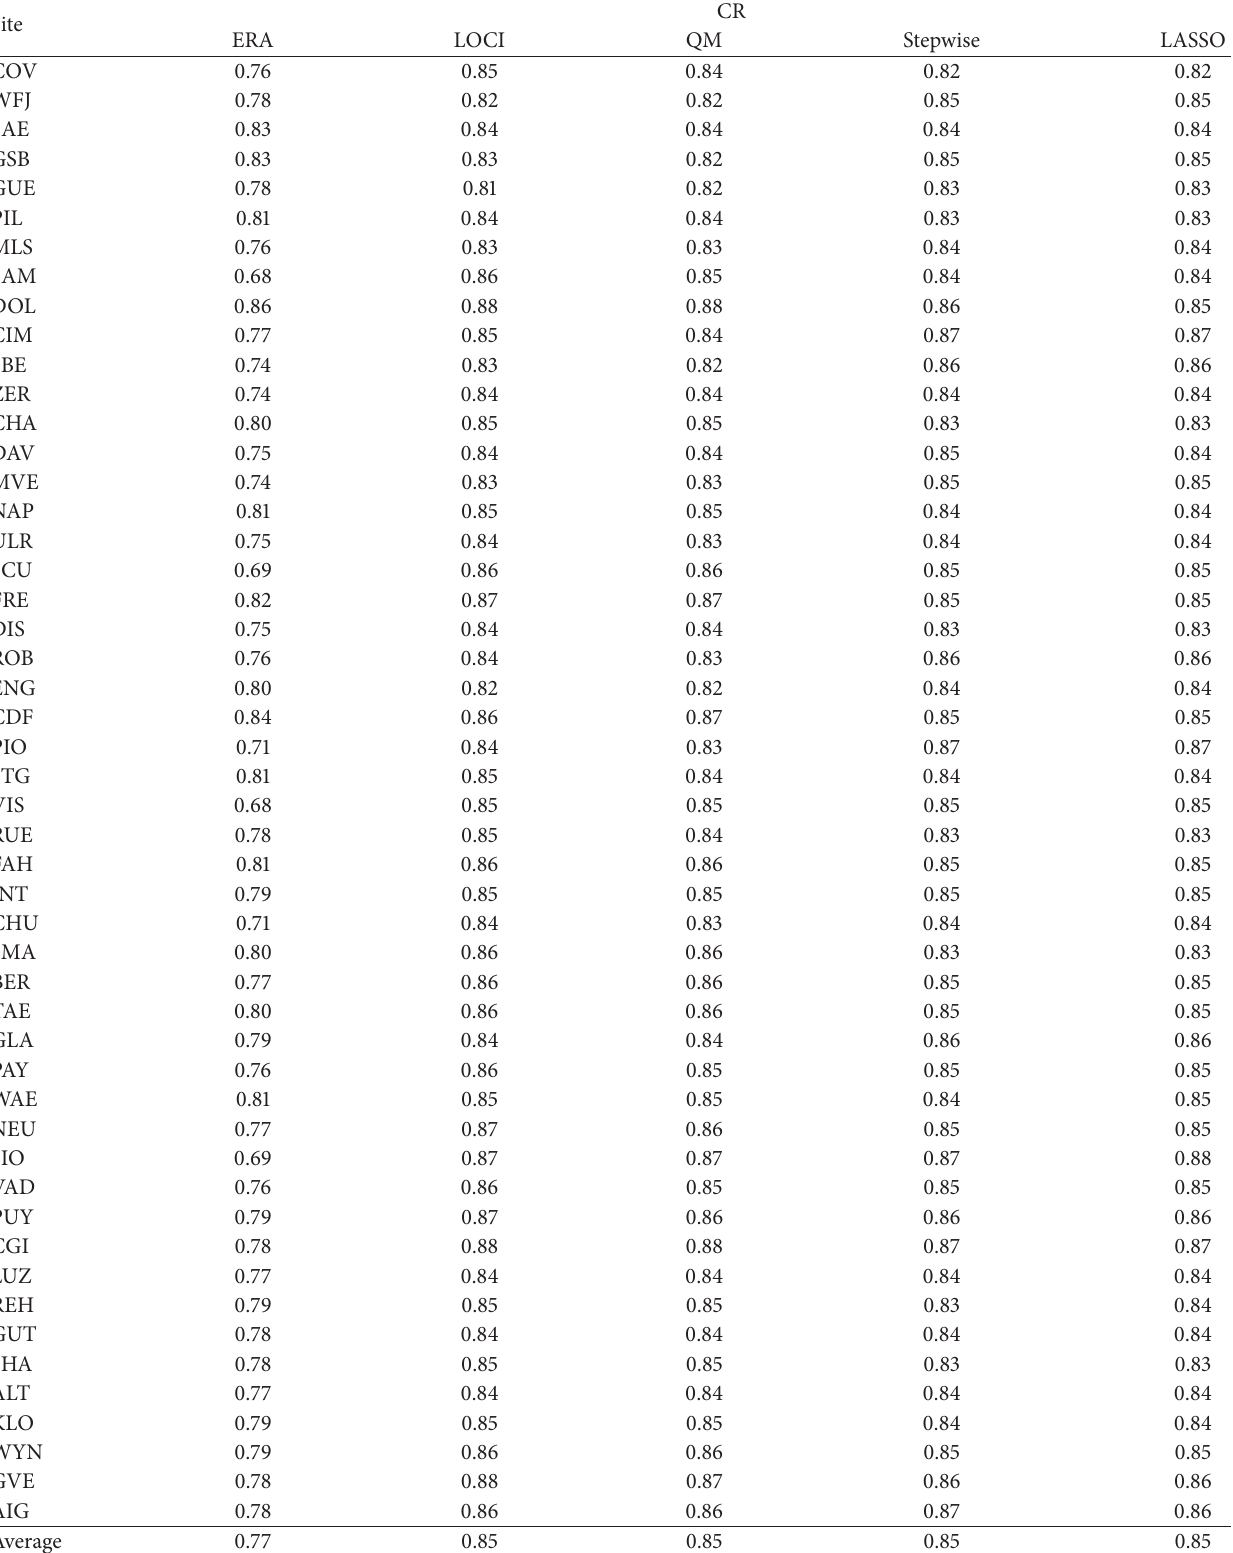
Table 4: Comparison of downscaling methods, as well as the original ERA-Interim forecast data in precipitation occurrence in the validation period